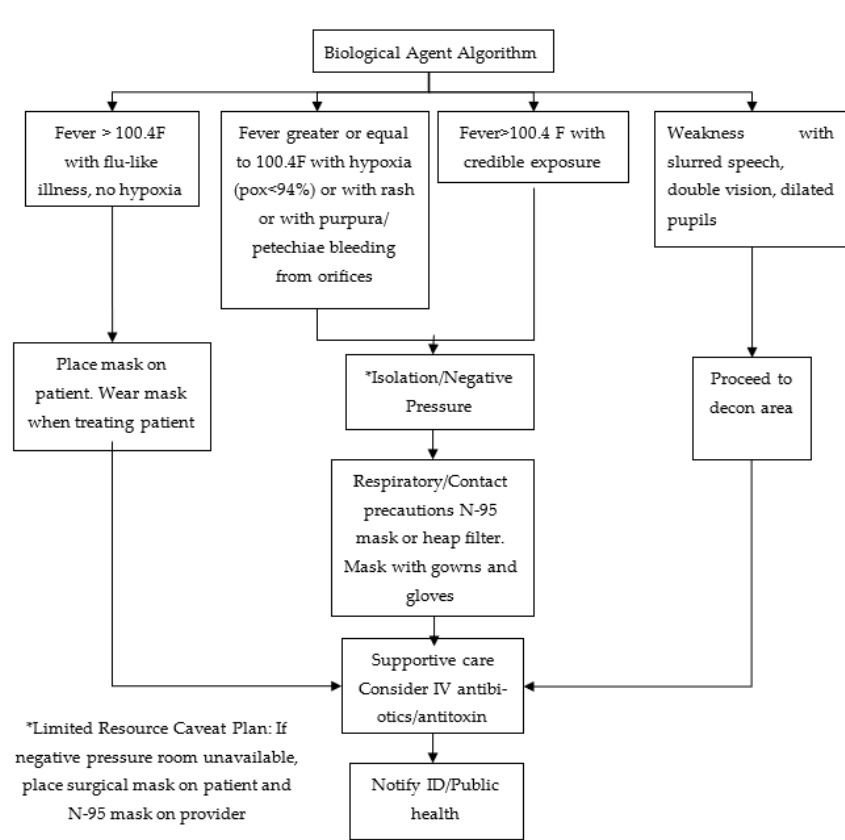
Figure 5. Triage algorithm under a bioterrorism